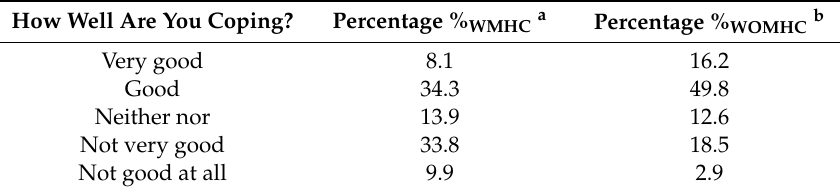
Table 4. Answers for item Coping (in percentage) for participants with (WMHC) and without (WOMHC) pre-existing mental health